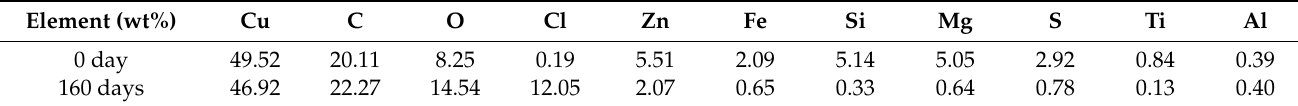
Table 4. EDS analysis results of the FW-1 topcoat surface for 0 d and 160 d testing.